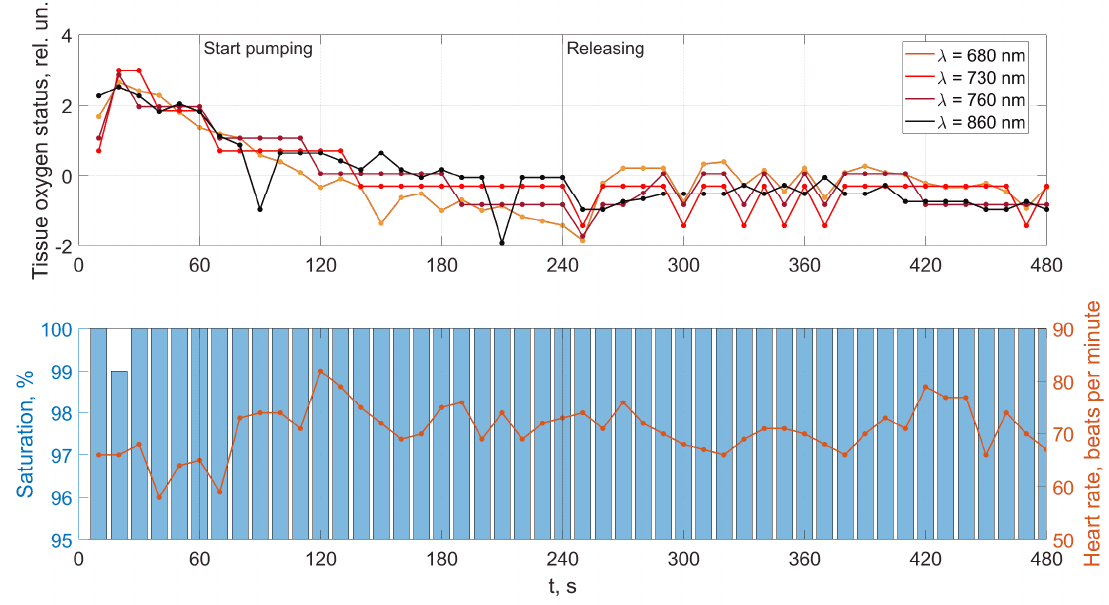
Figure 12. Dynamics of tissue oximetry parameters during the occlusion test for patient (a).